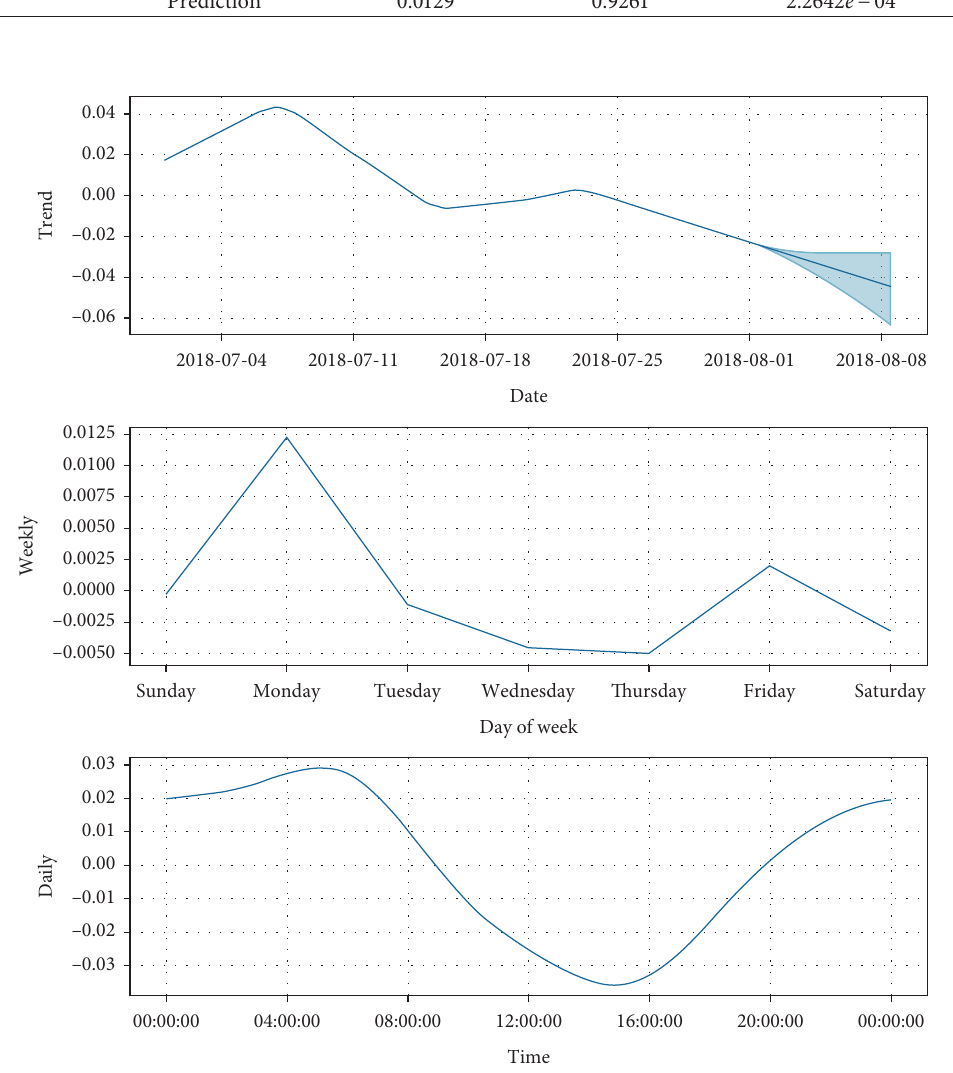
Figure 10: Trend and periodic components of ET phase